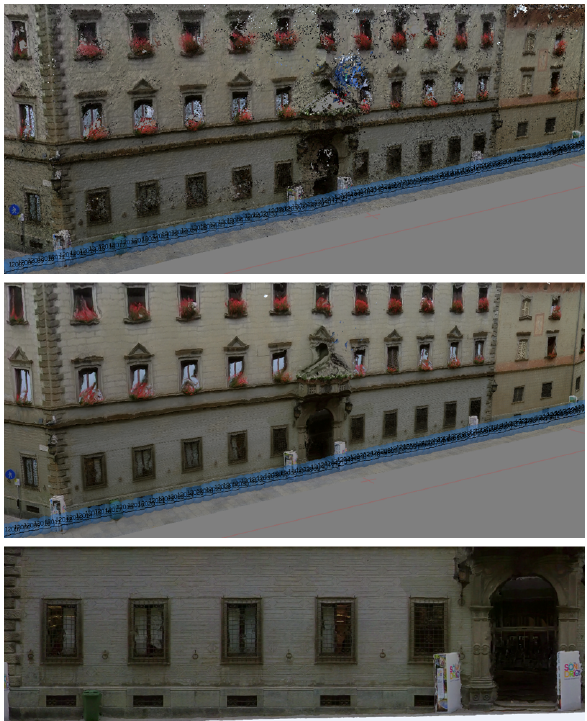
Figure 15: Dense cloud, mesh and orthophoto from about 100 spherical images in the Sondrio